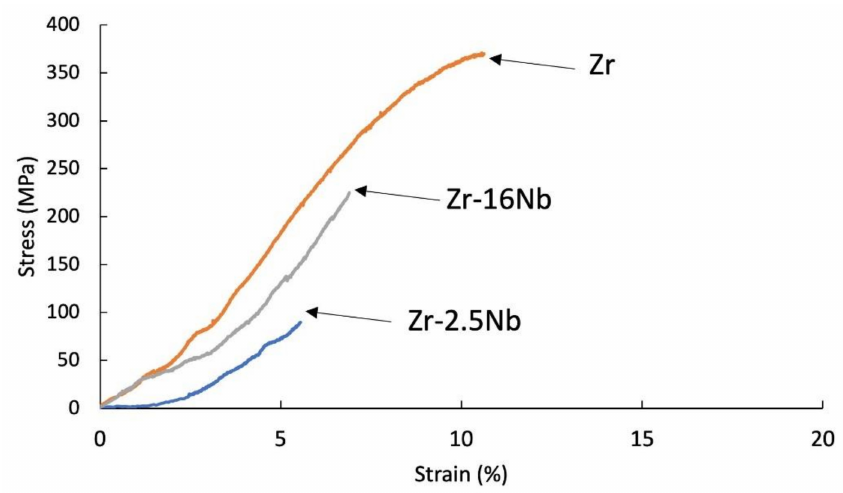
Figure 7. Tensile stress-strain curves of KOBO-extruded Zr-2.5 mass% Nb, Zr-16 mass% Nb, Zr materials; tests were carried at 400 ◦